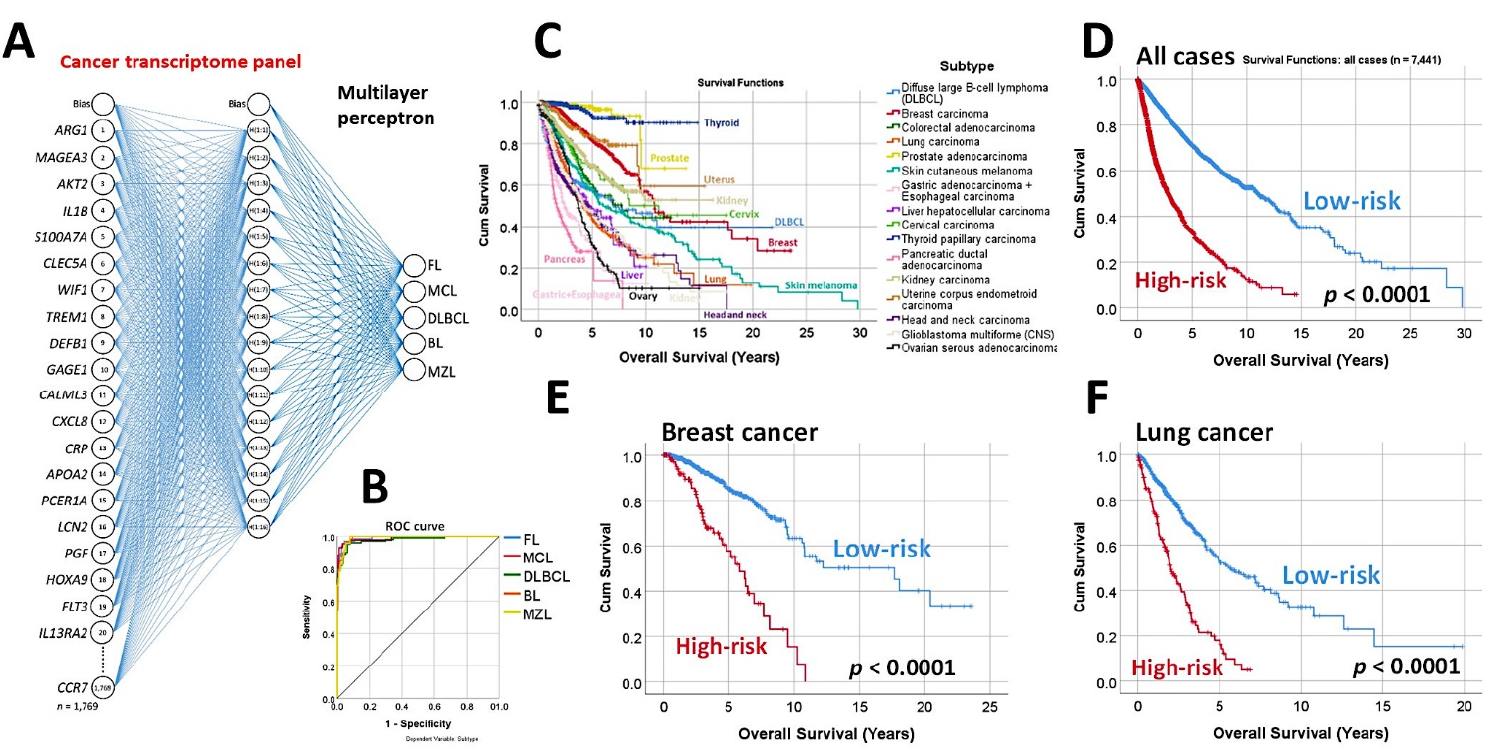
Figure 4. Prediction of lymphoma subtype by a neural network with high accuracy. ( A ) A multilayer perceptron predicted the different non-Hodgkin lymphoma subtypes, including follicular lymphoma, mantle cell lymphoma, diffuse large B-cell lymphoma, Burkitt’s lymphoma, and marginal zone lymphoma. The predictors (inputs) were the gene expression values of a pan-cancer transcriptome panel. The architecture of the network had 1769 nodes in the input layer, a hidden layer of 16 nodes, and an output layer with 5 nodes (5 lymphoma subtypes). In this figure, the top 20 most relevant genes for predicting the lymphoma subtype are shown, based on their average normalized importance for prediction. The most relevant gene was ARG1 , followed by MAGEA3 , AKT2 , and IL1B . ( B ) This multilayer perceptron had a high performance, as shown in the ROC curve that had an area under the curve near 1. ( C – F ) Interestingly, the top 30 genes of the neural network not only predicted the lymphoma subtype but also managed to predict the overall survival of a large pan-cancer series from the TCGA of 7441 cases. Using a risk score formula, the cases of each series were stratified into high- and low-risk groups. The risk scores were calculated by multiplying the beta values of the Cox regression per gene expression values for each gene. The overall survival was calculated using the Kaplan–Meier and log-rank test and Cox regression analyses. These top 30 genes belonged to a pan-cancer transcriptome panel. Therefore, this may explain why they have predictive value in a pan-cancer series, and points out that there may be common cancer mechanisms in all human